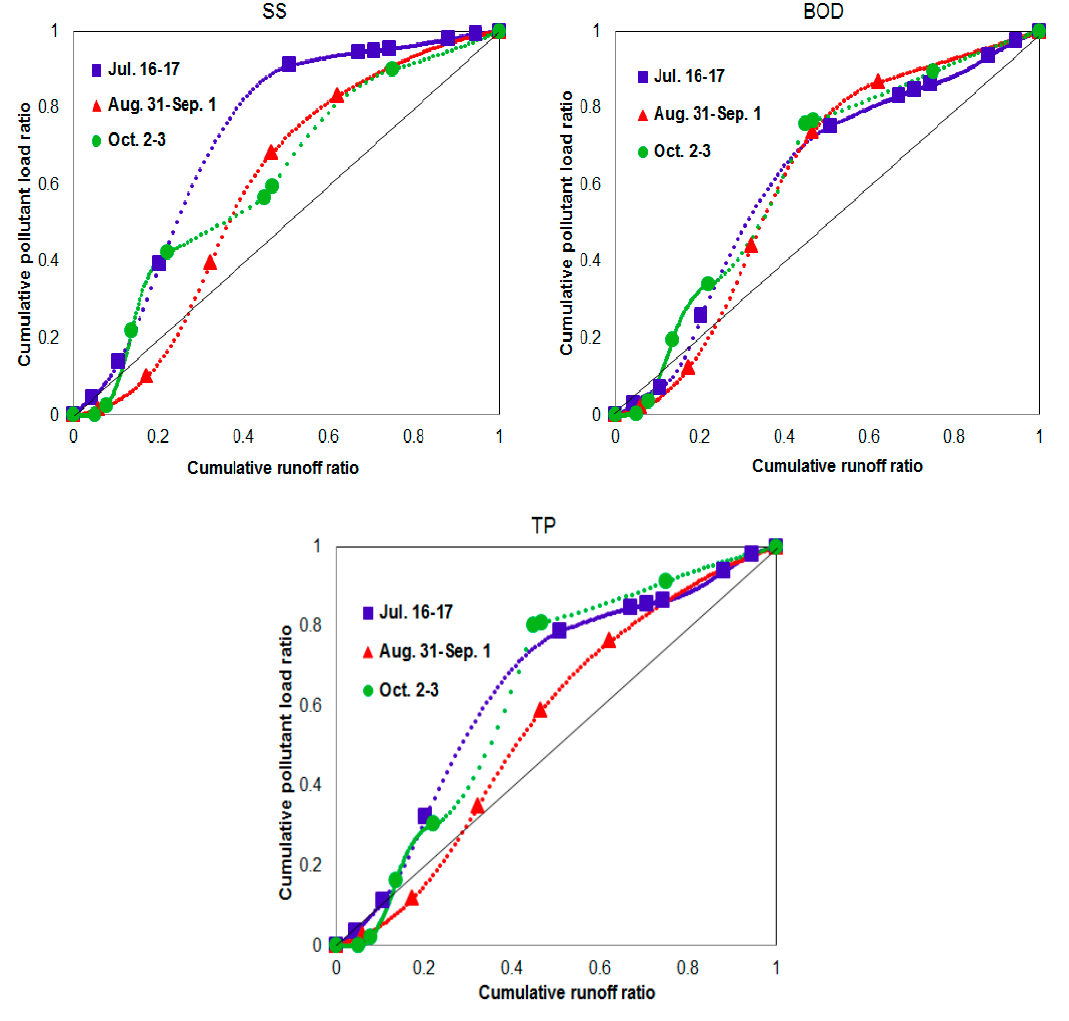
Figure 5. M(V) curve for Naedongcheon. Figure 5. M ( V ) curve for